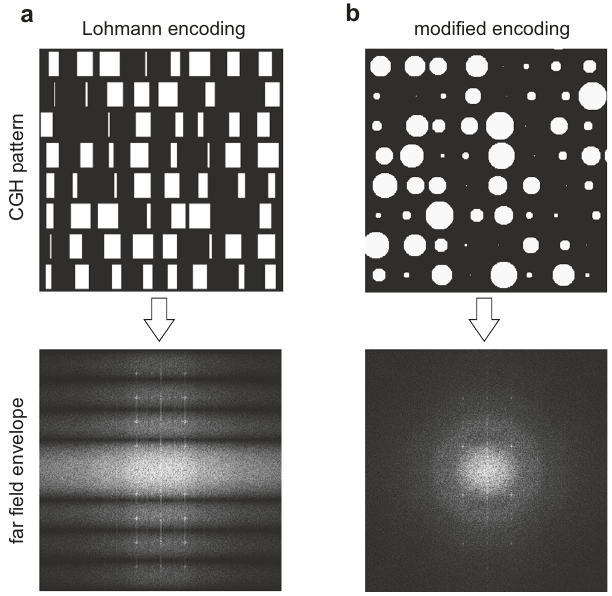
Fig.8|ComplexencodingofCGH. Shapingofthefar- fi eldintensityenvelopewith modi fi ed Lohmann encoding comprising circular